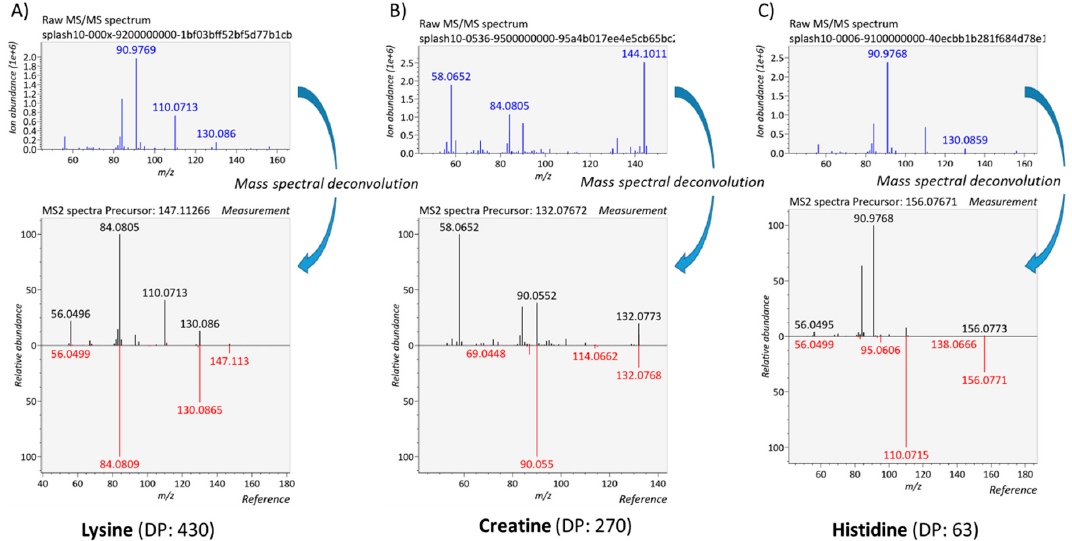
Figure 6. Deconvolution examples of DIA data. ( A ) Lysine with a good DP score, ( B ) creatine whose measured spectrum is contaminated by significant fragment ions arising from co-eluting and co-selected precursor ions but removed by an efficient deconvolution, and ( C ) histidine displaying a very low DP score due to the high abundance of fragment ions arising from other co-fragmented precursor ions.